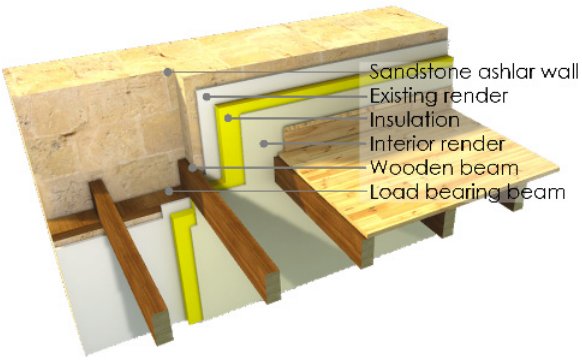
Figure 5. Geometrical description of the simulation model.